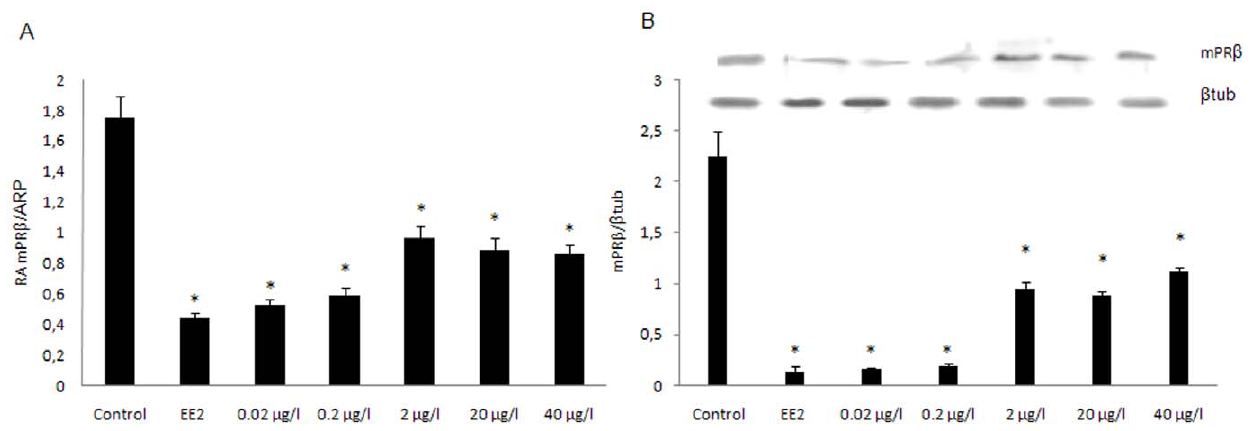
Figure 4. Effects of DEHP exposure on the expressions of ovarian mPR b in female zebrafish. A, Female zebrafish were exposed to DEHP (0.02, 0.2, 2, 20 and 40 m g/l) or EE2 (25 ng/l). Data were shown as mean 6 SD. Asterisks* indicate statistical significant differences to control group (p , 0.05). B, Insert shows a representative Western blot while the graph represents densitometric analysis of mPR b normalized using b -tubulin. Data are expressed as the mean 6 SD from at least four separate experiments. Asterisks* denote exposure groups that are significantly different from the control group (p , 0.05).